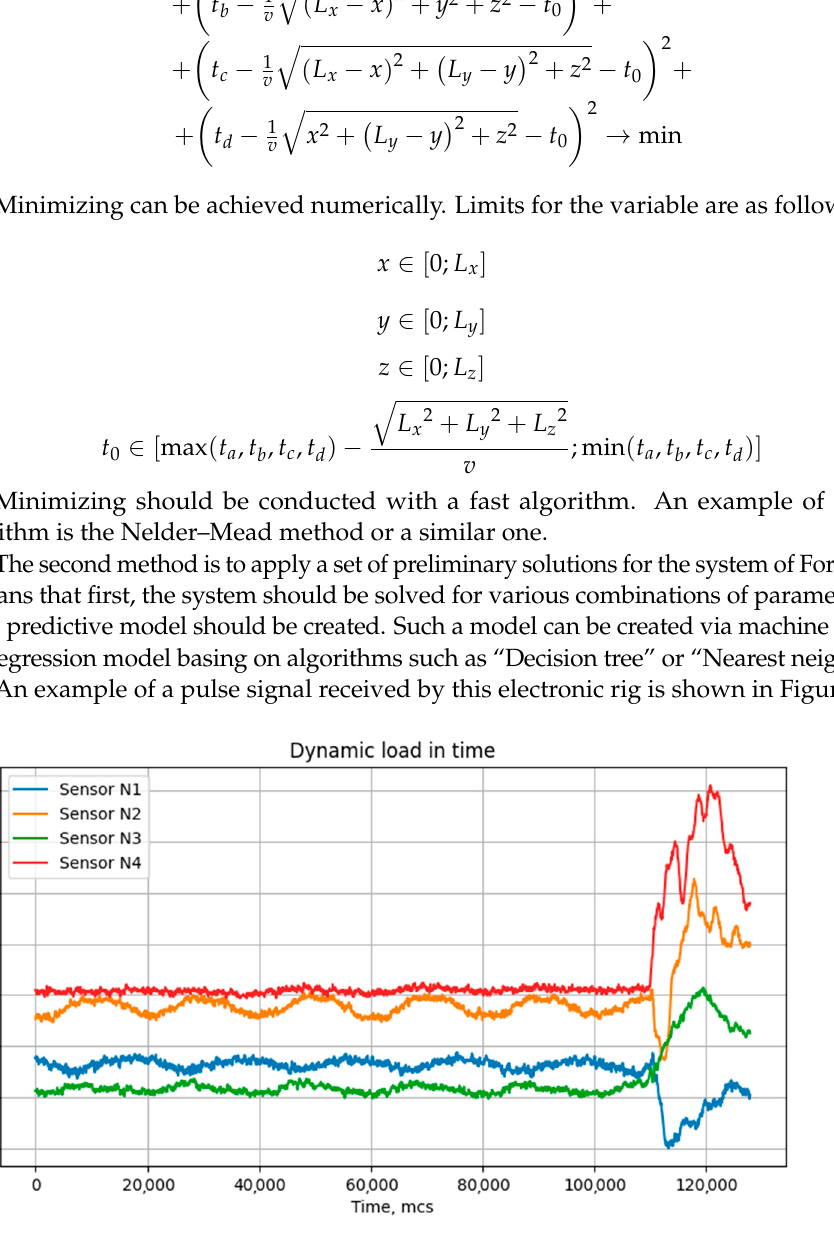
Figure 11. Dynamic load in time for each of four strain gauge sensors.